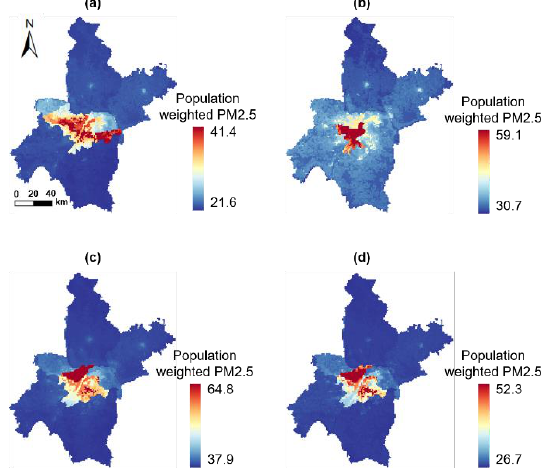
Figure 4. Population exposure to PM2.5 concentration within Wuhan in (a) 2000, (b) 2005, (c) 2010 and (d) 2015.